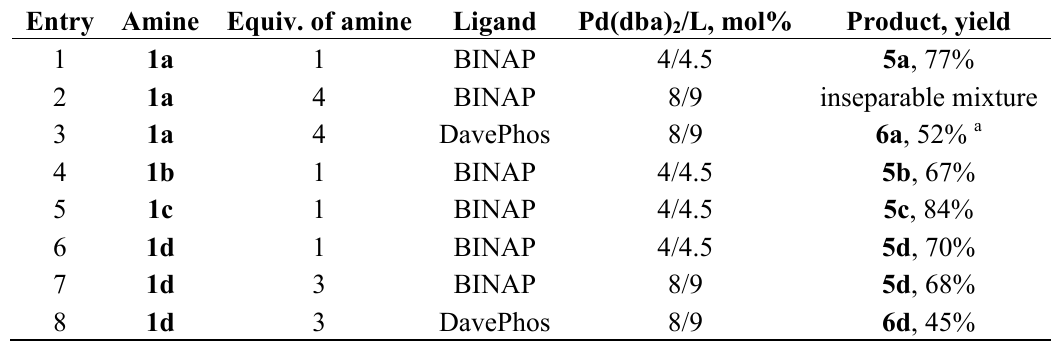
Table 2. Pd-catalyzed amination of